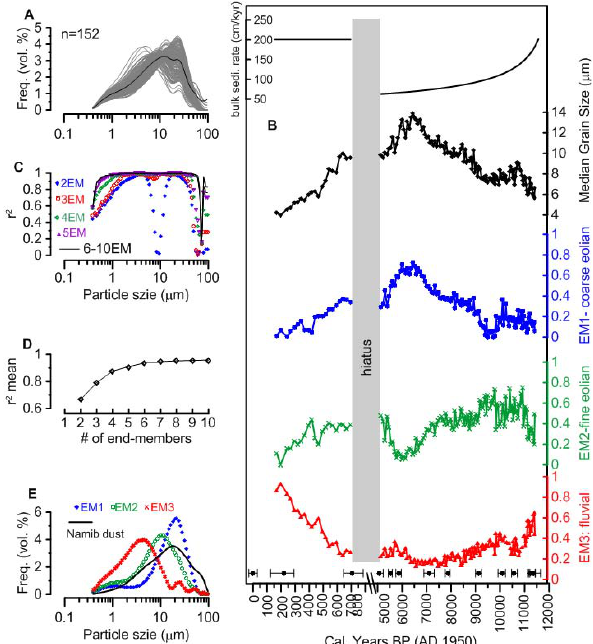
Fig. 3. Results of grain size analysis and end-member modeling for core GeoB8332-4 material. (A) Grain size distribution frequency for 152 samples (gray lines) and average grain size distribution fre- quency for the entire data set (black line). (B) Sedimentation rate of buld sediment, temporal distribution of median grain size and mod- eled end-members 1–3, indicating coarse eolian (EM1), fine eolian (EM2), and fluvial (EM3) components. Black filled circles and hor- izontal bars indicate age model control points and error estimate (2 σ) obtained from 14 C datings and conversion to calendar age. (C) r 2 goodness of fit of models with 2–10 end-members for each particle size class. (D) r 2 mean (mean coefficient of determination) of all size classes for each end-member model. (E) Comparison of particle size distributions in EM1, EM2, and EM3 with present-day dust collected over the Walvis Ridge (Stuut et al.,